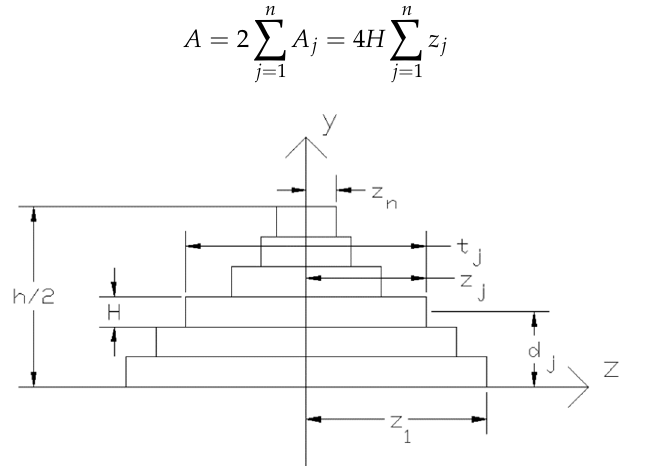
Figure 5. Discretized cross-section.